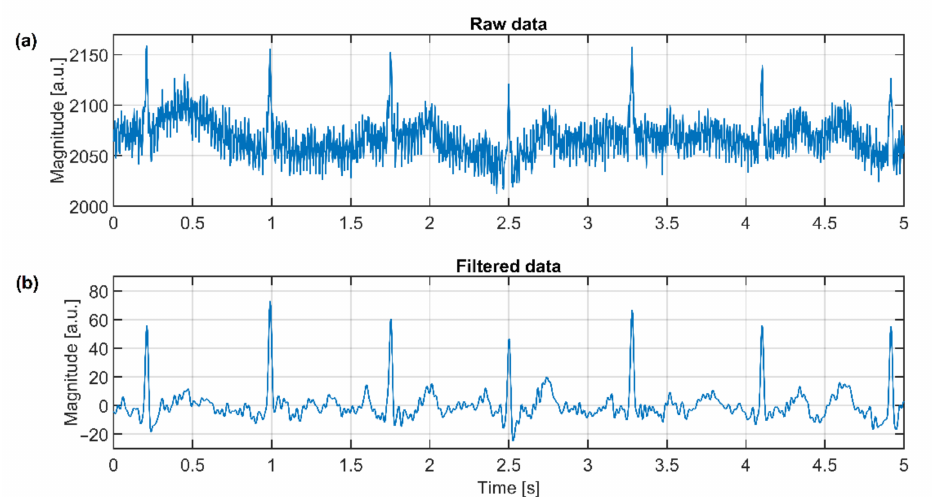
Figure 19. Raw ECG signal ( a ) and filtered signal ( b ) acquired by the capacitive system using the DRL electrode.